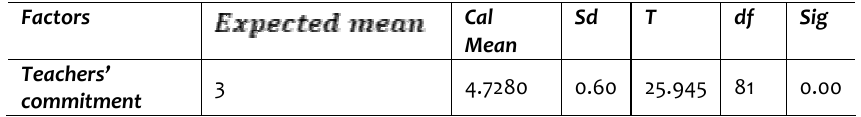
Table 2 - One sample t-test analysis of the contribution of teachers` commitment to students’ academic